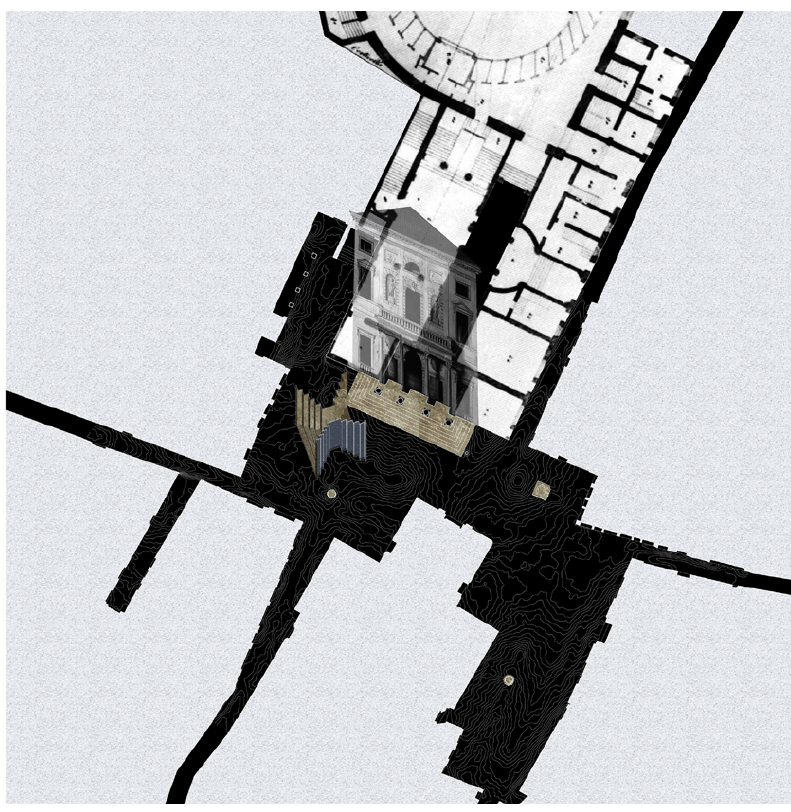
FIG. 7 Campo San Fantin, axonometry with insertion of the quadruple module. Drawing and montage edited by the author, scale